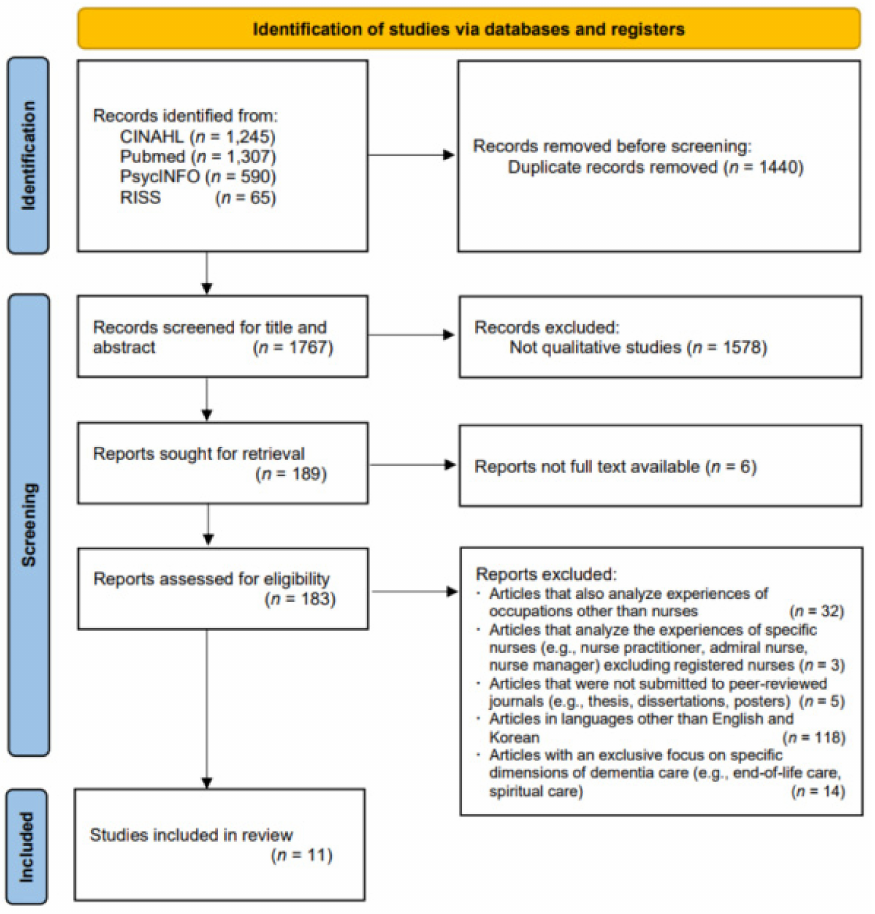
Figure 1. Flowchart of the Preferred Reporting Items for Systematic Reviews and